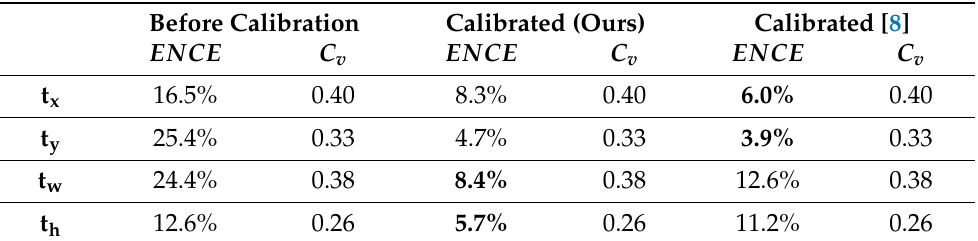
Figure 2. Reliability diagrams for bounding box regression on the KITTI validation set before and after calibration. Each plot compares the empirical RMSE and the root mean variance ( RMV ) in each bin. Grey dashed line indicates the ideal calibration line [8]. See Section 4.2 for details. Table 1. Evaluation of uncertainty calibration for the bounding box regression tasks on the KITTI validation